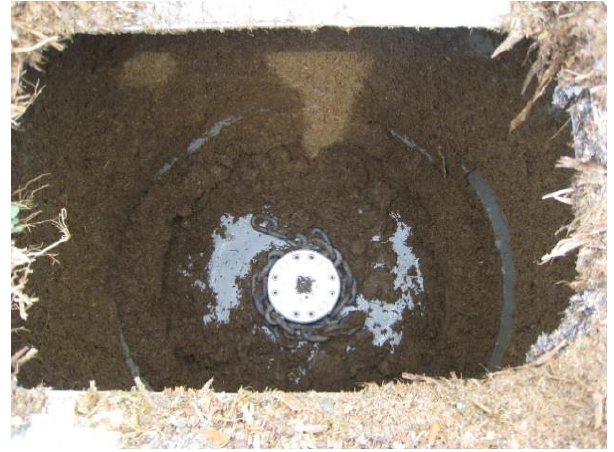
Figure 2. Crushing of biomass in a crusher.